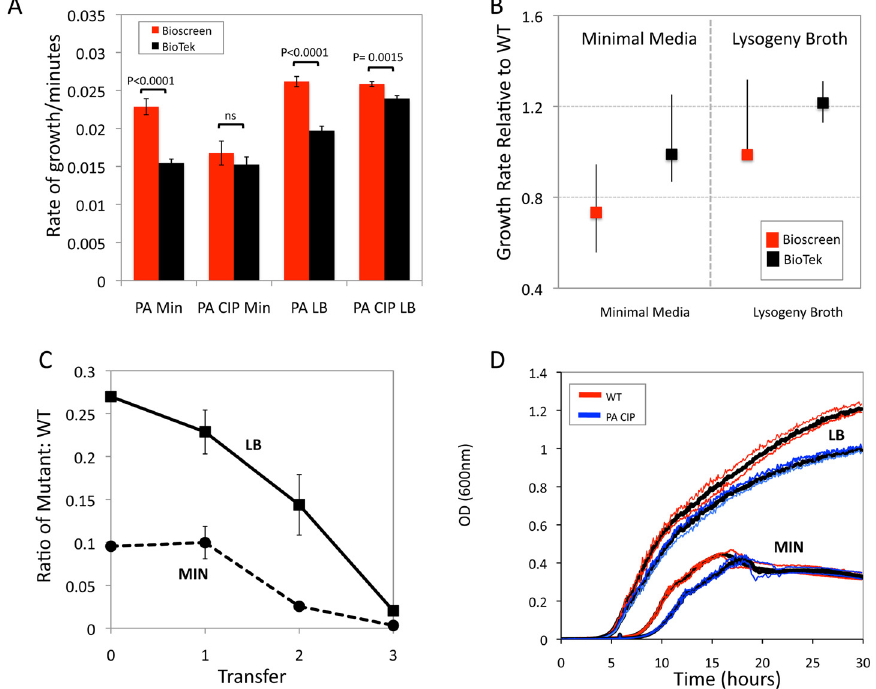
Fig 4. Malthusian parameter and pairwise competition estimates of fitness for Pseudomonas aeruginosa ciprofloxacin susceptible and resistant mutants in LB and glucose-limited minimal medium. (A) Estimates of the absolute MP of WT and PA-CIP obtained with a Bioscreen (red bars) and BioTek (black bar) plate readers. (B) MP of PA-CIP of relative to wild type P . aeruginosa in glucose-limited minimal medium and LB, Bioscreen red and BioTek black. (C) Pairwise competition, ratio of PA-CIP strain relative to wild type in LB and minimal medium, mean and standard deviation of the ratios from three independent competition experiments. (D) Longer term changes in OD of CIP resistant and sensitive strains in minimal medium and LB, Bioscreen